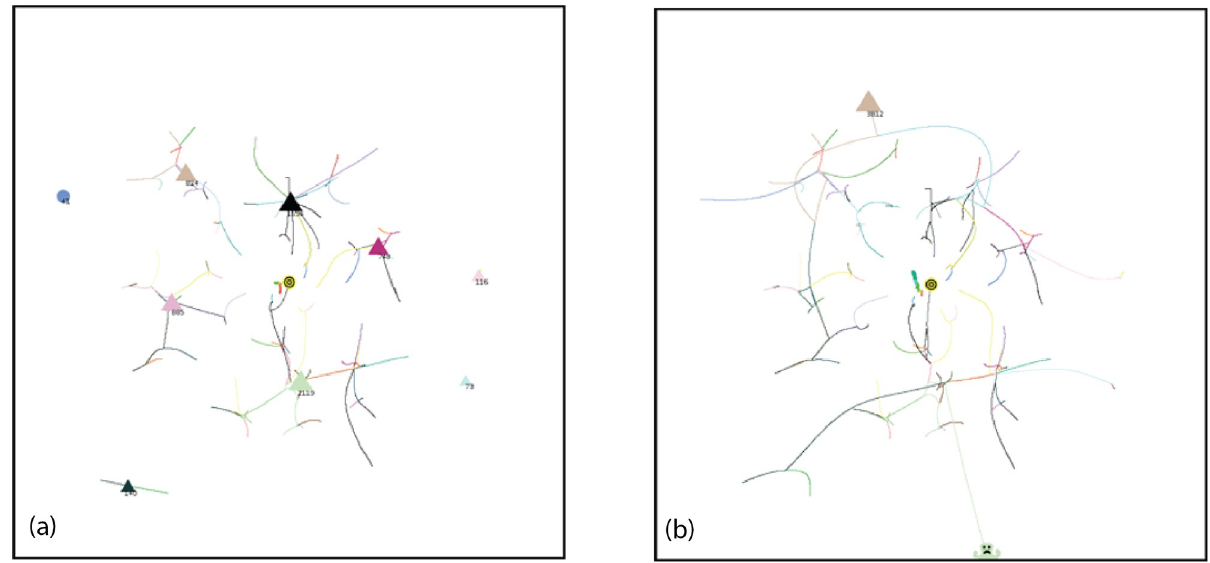
Fig 21. Effect on final state of adding one agent to the initial configuration. a) AIB = 30, agent of mass 500 added at (0,30). Compare to Fig 11a. b) AIB = 180, agent of mass 100 added at (0,30). Compare to Fig 11b.